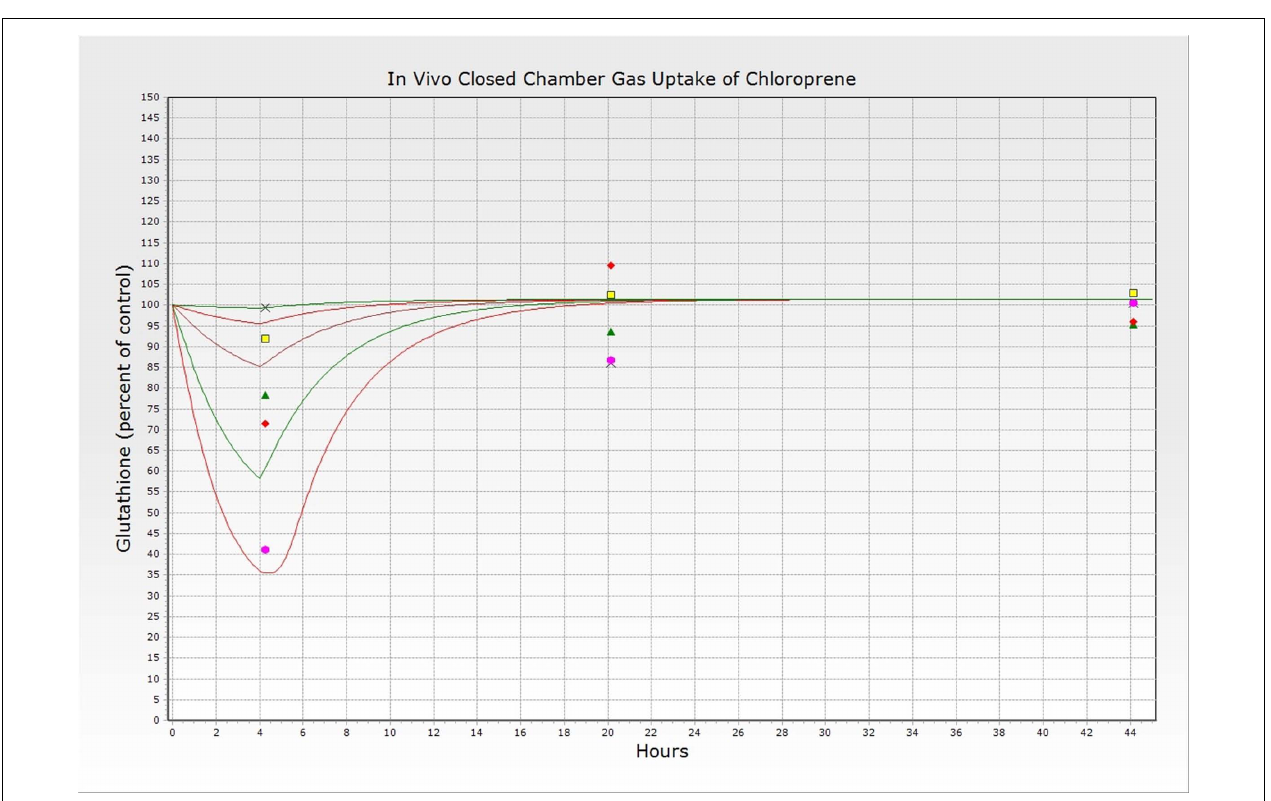
FIGURE 14 | Reproduction of Figure 5 from Clewell et al. (2001). Simulations (lines) and experimentally determined (symbols) glutathione concentrations (as percent of control animal levels) at 0, 20, and 44h following 4-h inhalation exposures toVC at exported in acslX Libero version